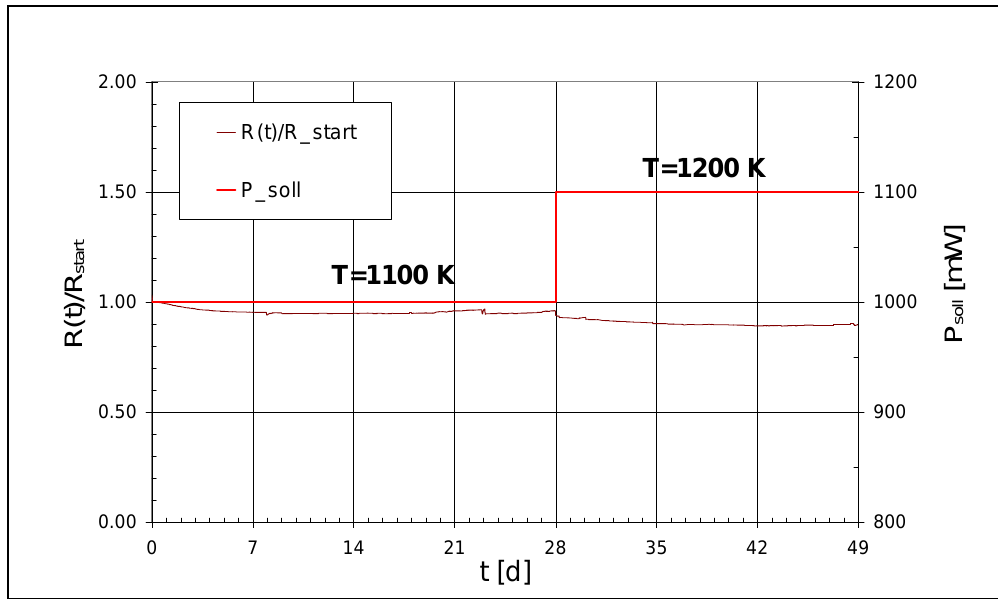
:Sb based heaters in comparison to Pt ones. During this Figure 9. Long-term stability of SnO 2 experiment, the SnO :Sb emitter was unprotected and directly exposed to the ambient atmosphere. The 2 :Sb emitter are caused by changes in air flow and humidity. resistivity variations of the SnO 2